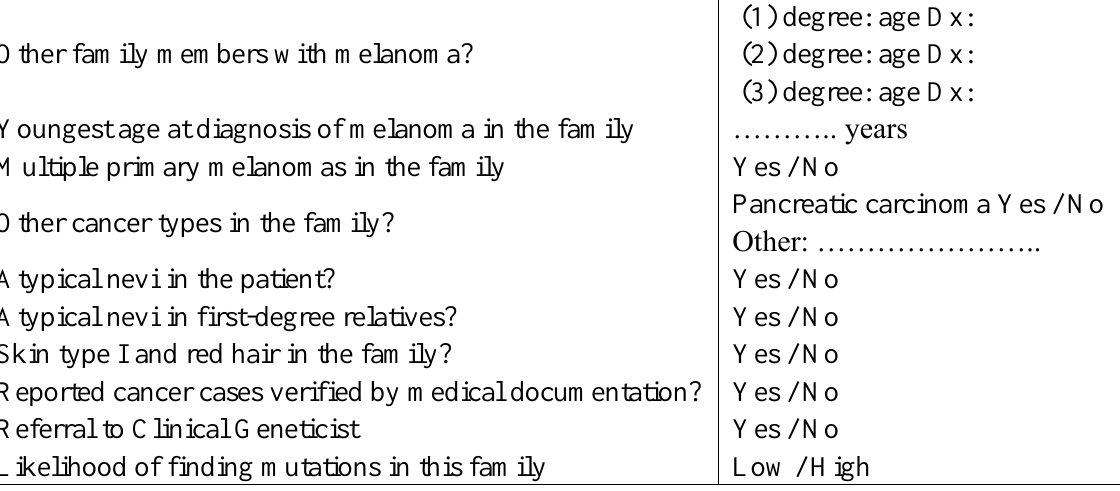
Table 1. Checklist to identify possible new melanoma-prone families. Other family members with